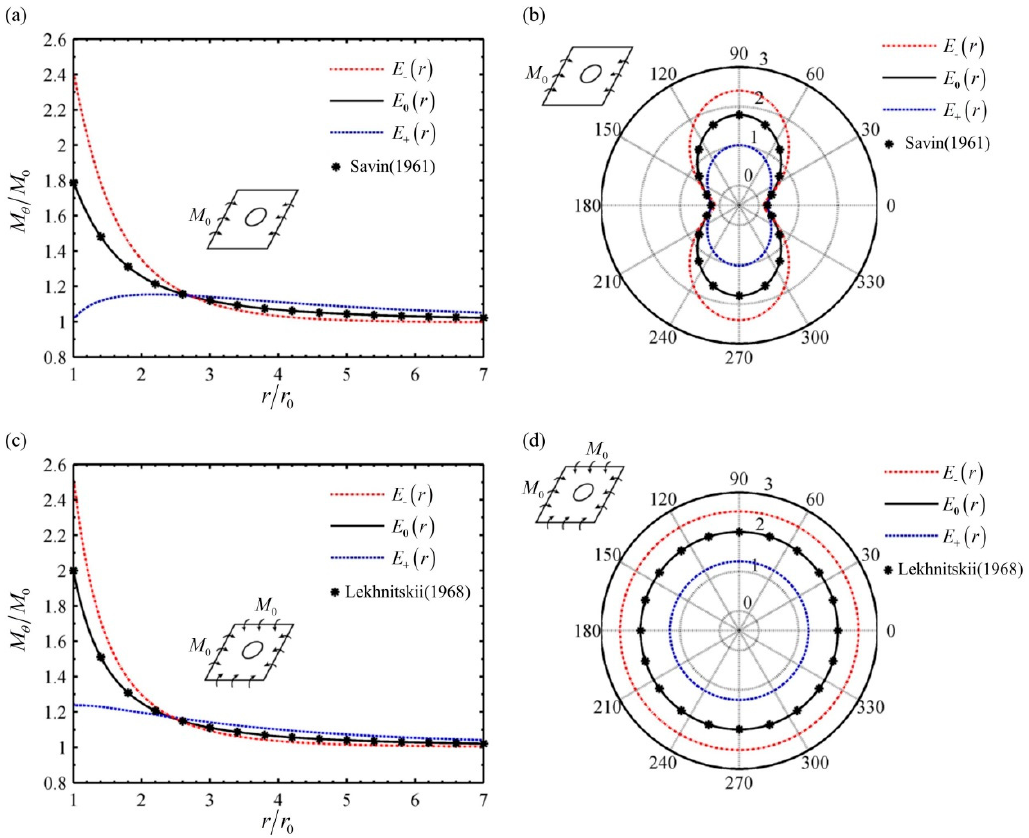
Figure 3. Distribution of moments M θ / M 0 for di ff erent varying Young’s modulus: ( a ) distribution along the radial direction under uniaxial bending ( θ = ± 90 0 ); ( b ) distribution around the hole under uniaxial bending; ( c ) distribution along the radial direction under balanced biaxial bending; ( d ) distribution around the hole under balanced biaxial bending.